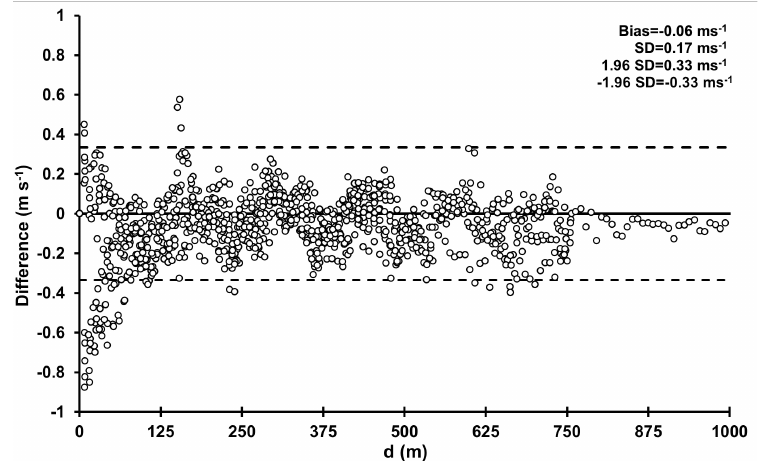
Figure 8. Dispersion of the modelled from measured velocity v w vs. the distance travelled for both runs of all six athletes. Black lines indicate upper and lower limits of the 95%-confidence interval.